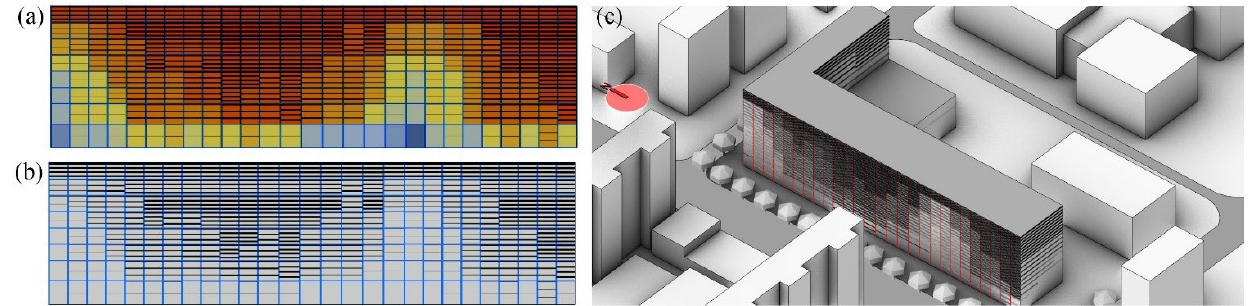
Figure 14. The shading form translated by meteorological data under the control of parametric design. ( a ) Radiation simulation of the façade; ( b ) Shading system generation based on radiation result; ( c ) Simulation result of shading performance.